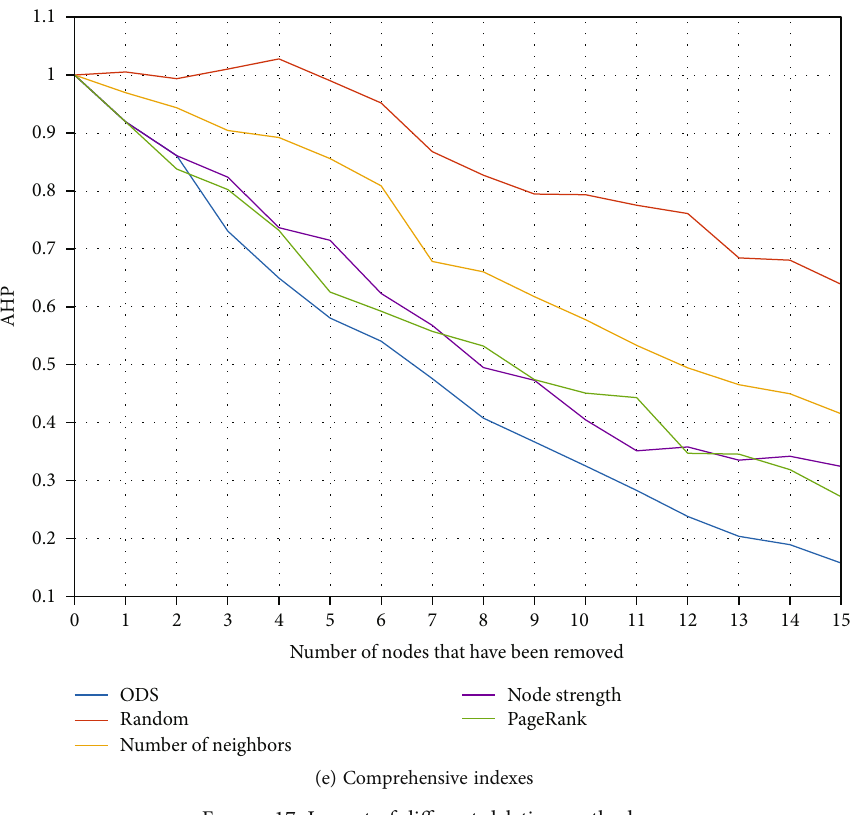
Figure 17: Impact of di ff erent deletion